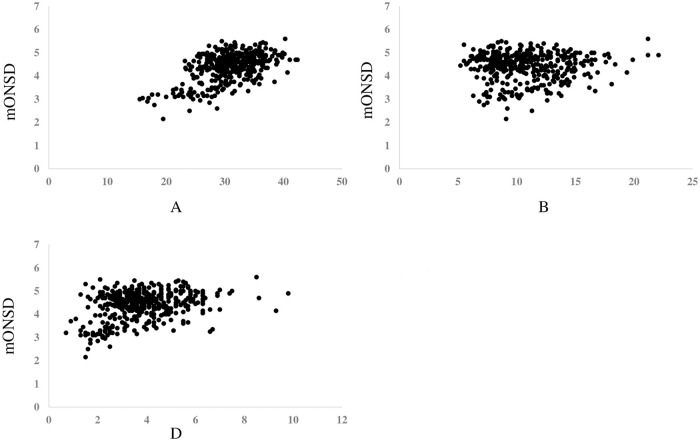
Mean optic nerve sheath diameter of those in normal control plotted in relation to the width of the ventricles, revealing that mONSD was weakly correlated with A, however absent in linear correlation in B and D.Results of regression analysis and Spearman’s rank correlation analysis is shown in separate table. mONSD; mean optic nerve sheath diameter, A: Maximum distance between anterior horn, B: Minimum bicaudate nuclei distance, D: Third ventricle distance.